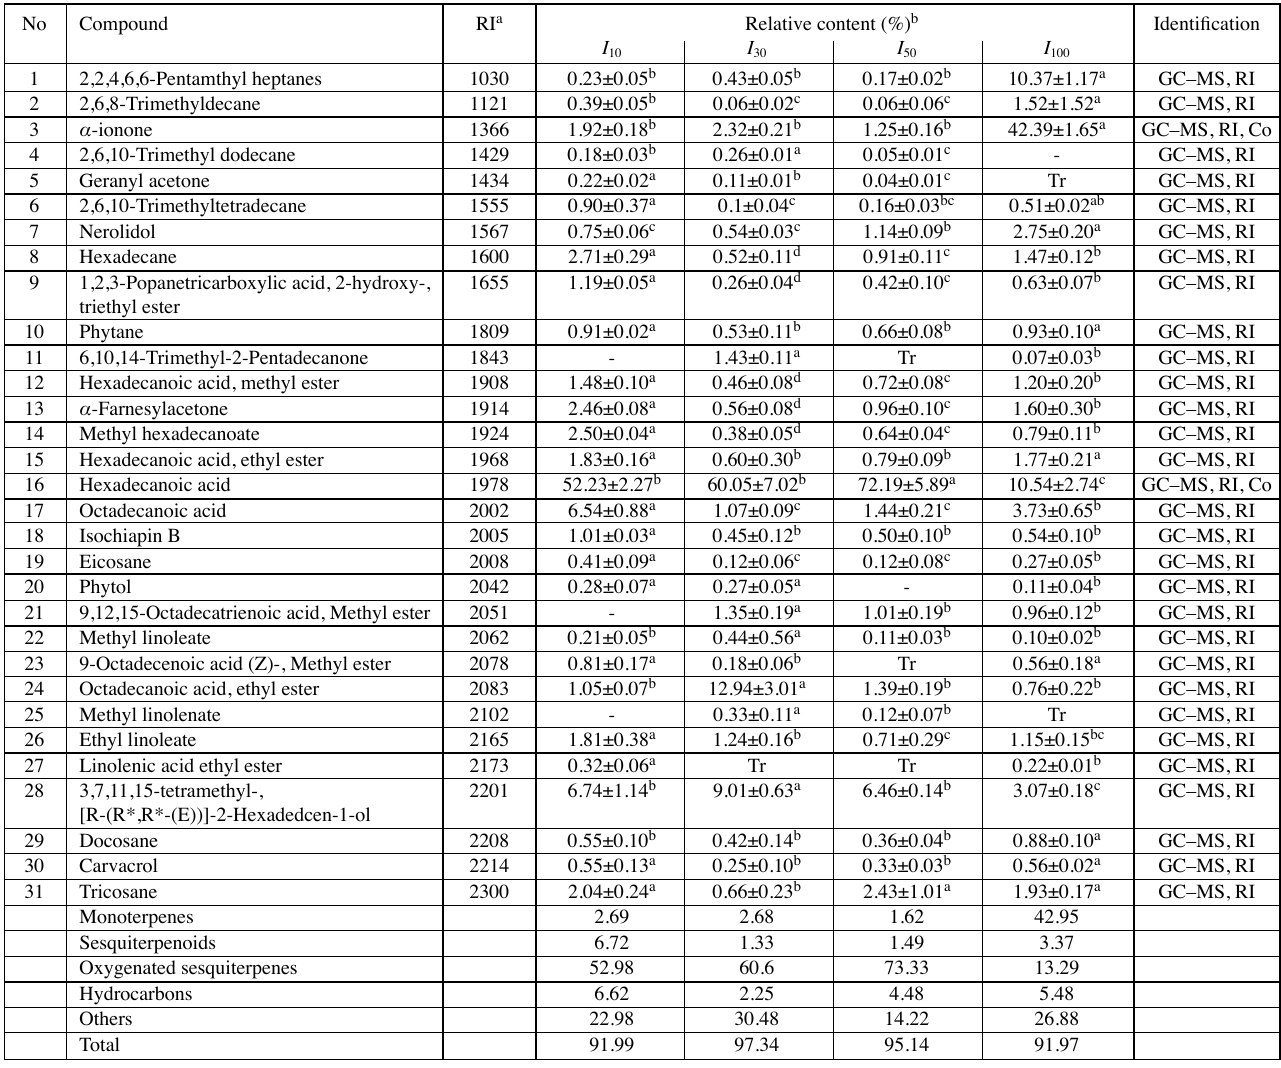
Tab. 3: Chemical constituents (%) of essential oil in leaves of M. breviracema under different light intensities.